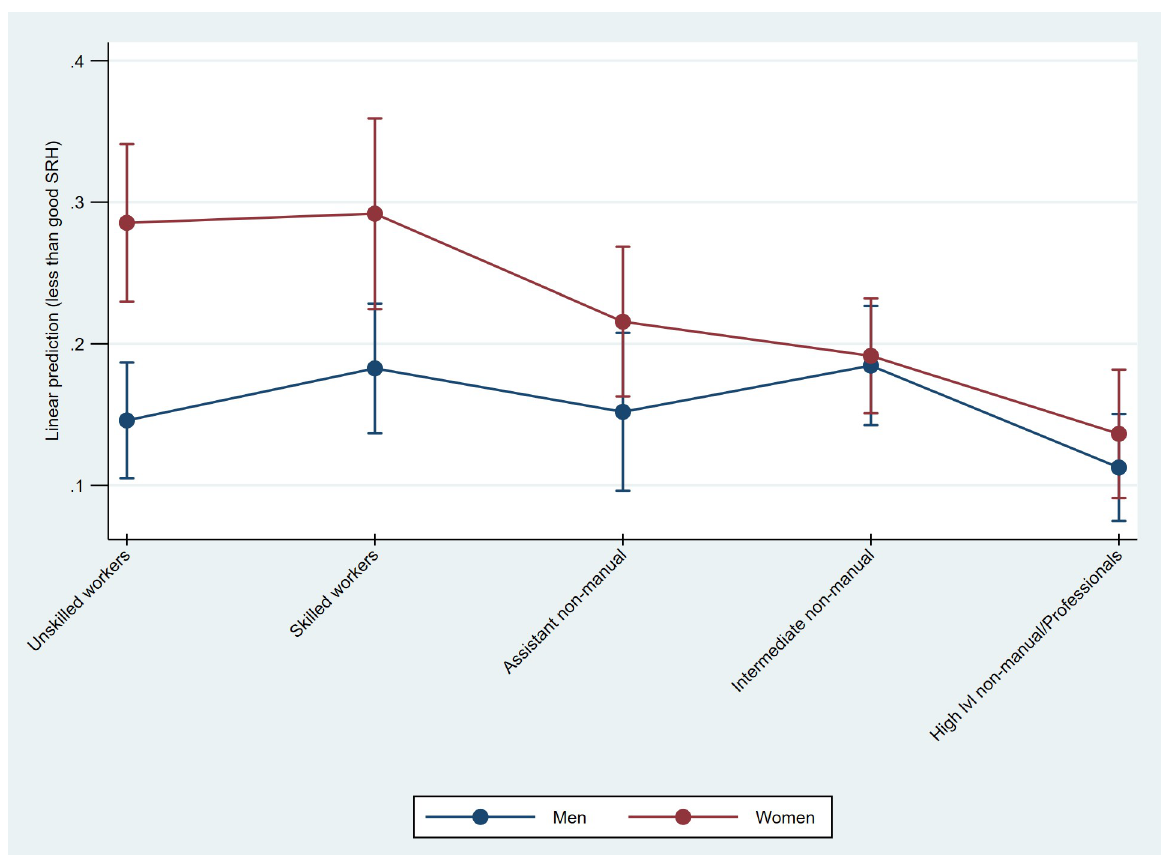
Fig 3. Predicted probabilities of less than good SRH, by gender and class. Marginsplot based on linear probability model with mutual adjustment for gender and class (Table C in S3 Appendix).